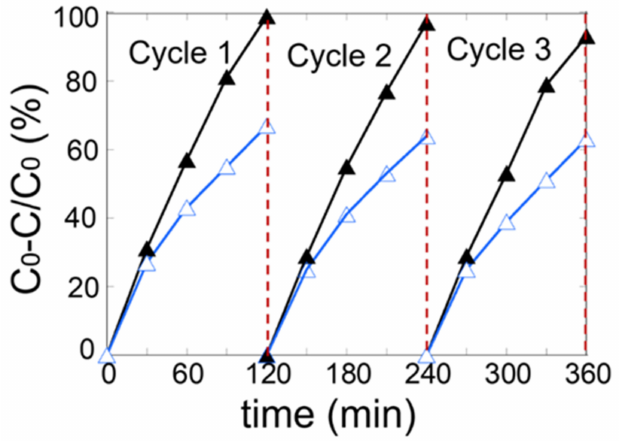
Figure 9. Recycling of Ag_MgGaAl photocatalyst for 4-NPh ( ∆ ) and p-DCB ( (cid:78) )